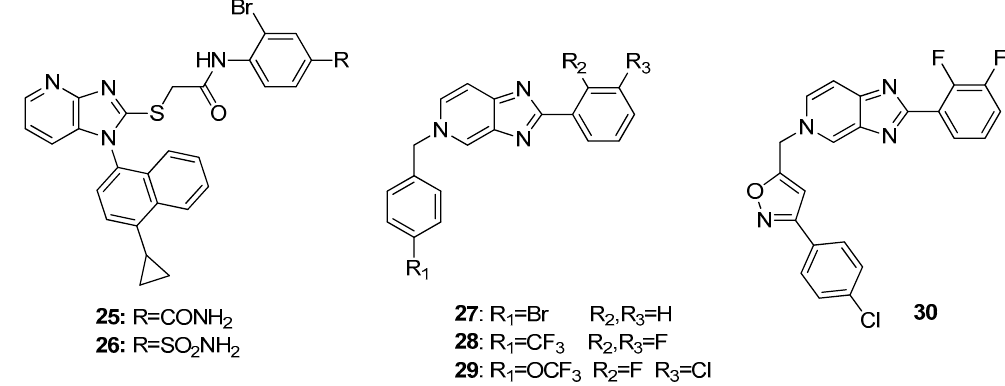
Figure 9. Antiviral imidazo[4,5- b ]pyridines and imidazo[4,5- c ]pyridine derivatives.